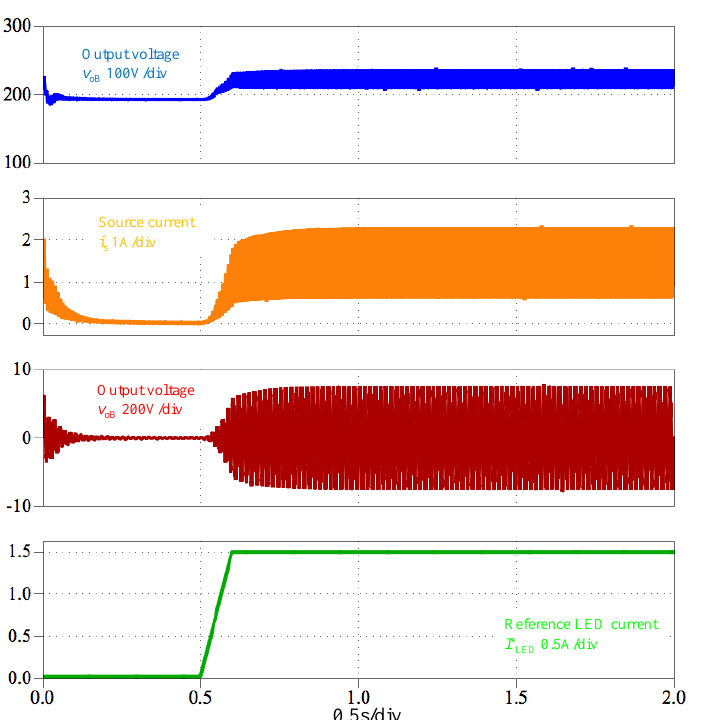
Figure 12. Simulation waveforms when the reference LED current I ∗